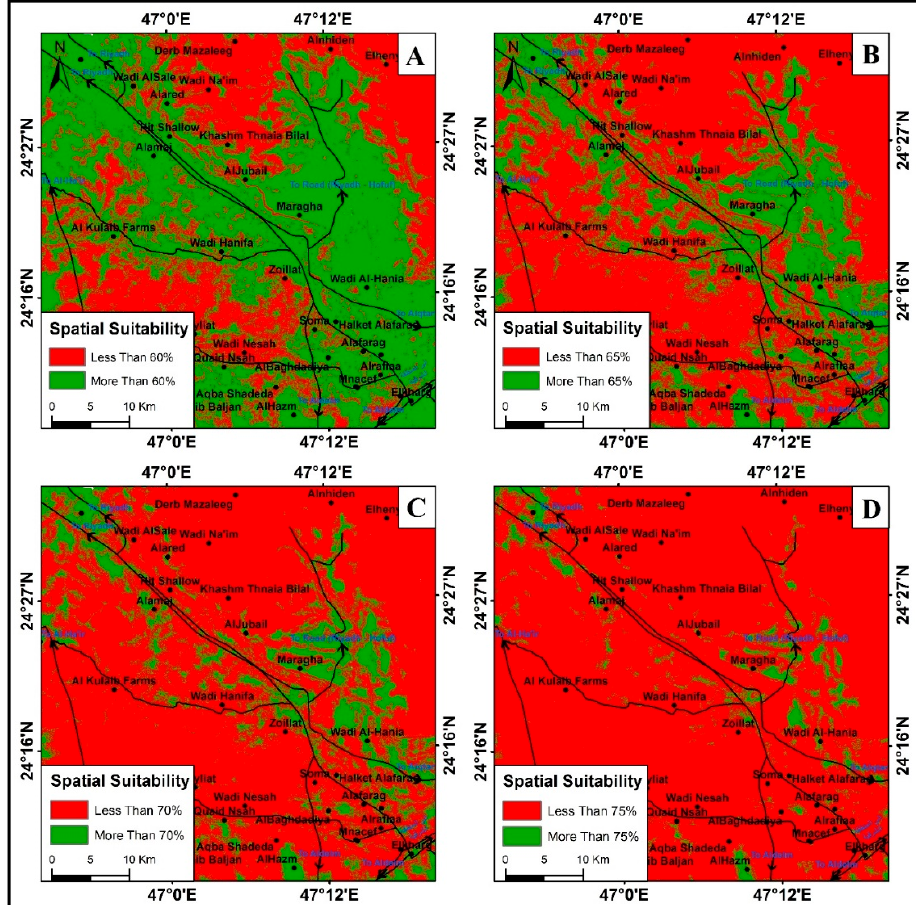
Figure 13. Levels of spatial suitability for sustainable urban development in the rural–urban continuum (Ar Riyadh–Al Kharj), 2019: ( A ) less than 60% / more than 60%), ( B ) less than 65% / more than 65%, ( C ) less than 70% / more than 70%, ( D ) less than 75% / more than 75%. Table 9. Relative importance to spatial suitability for constructing new urban areas in the Ar Riyadh– Al kharj urban–rural continuum.